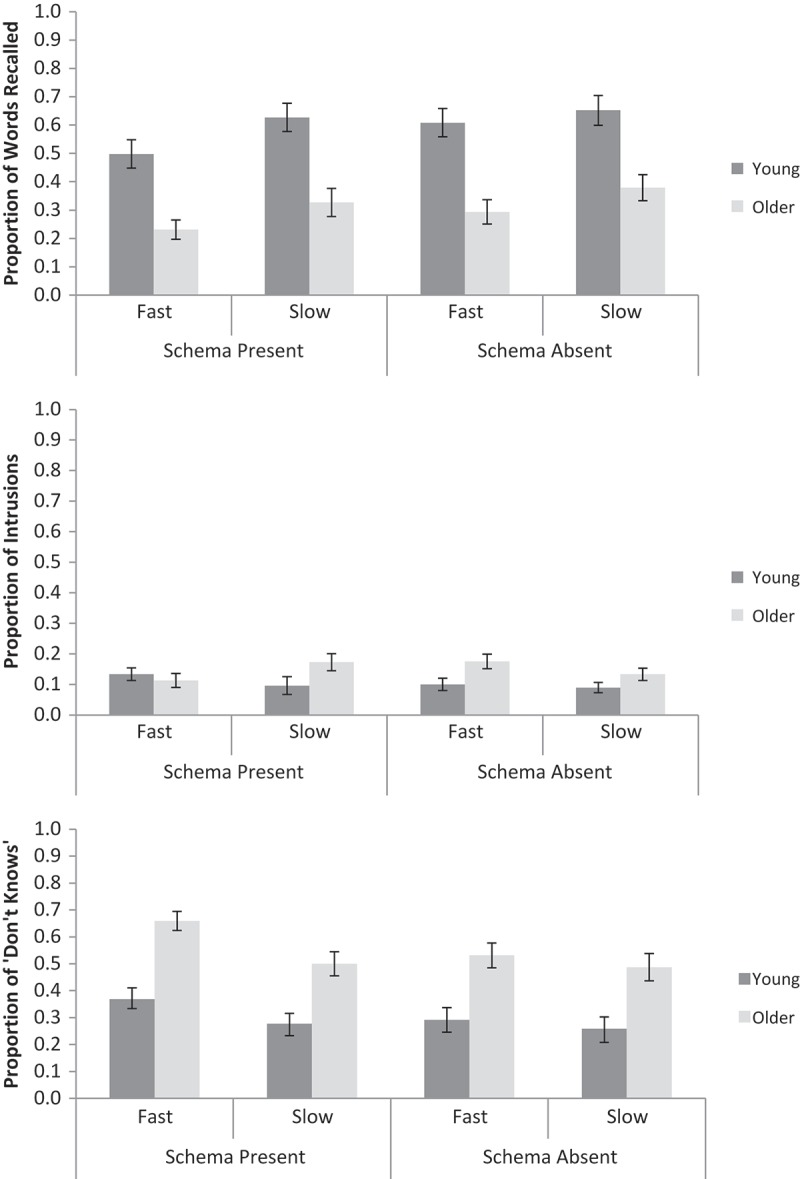
The proportion of words correctly recalled (top), intrusions (middle), and “don’t know” responses (bottom) for schema-present and schema-absent conditions, fast and slow encoding speeds, and young and older adults in Experiment 1. Error bars are ±1 SE.